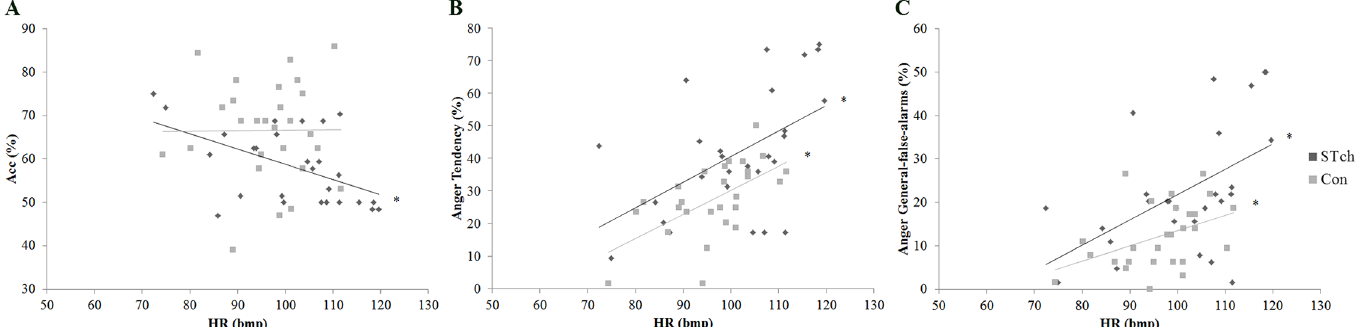
Fig 8. HR predicts behavioral performance. A) Plot of HR versus average Accuracy rate for street-children (STch) and controls (Con); B) Plot of HR versus Anger Tendency rate for street-children (STch) and controls (Con); C) Plot of HR versus Anger General-false-alarms rate for street-children (STch) and controls (Con). * = p <